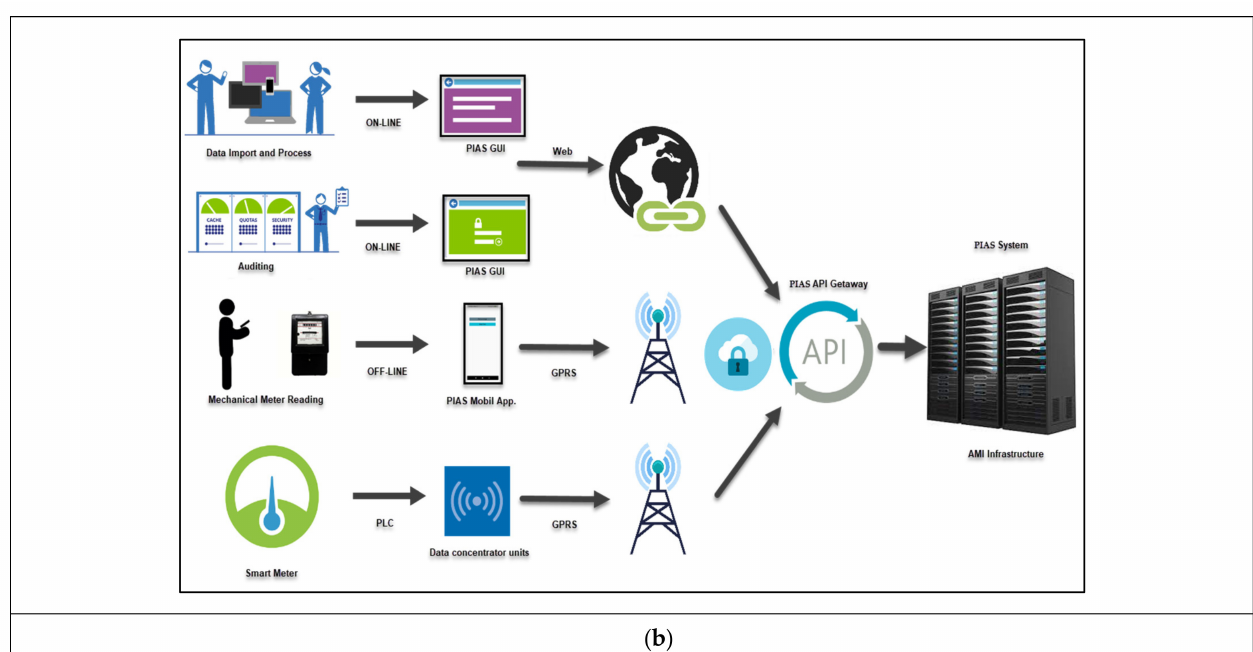
Figure 2. PIAS Data Acquisition. ( a ) Acquisition Block Diagram. ( b ) Process